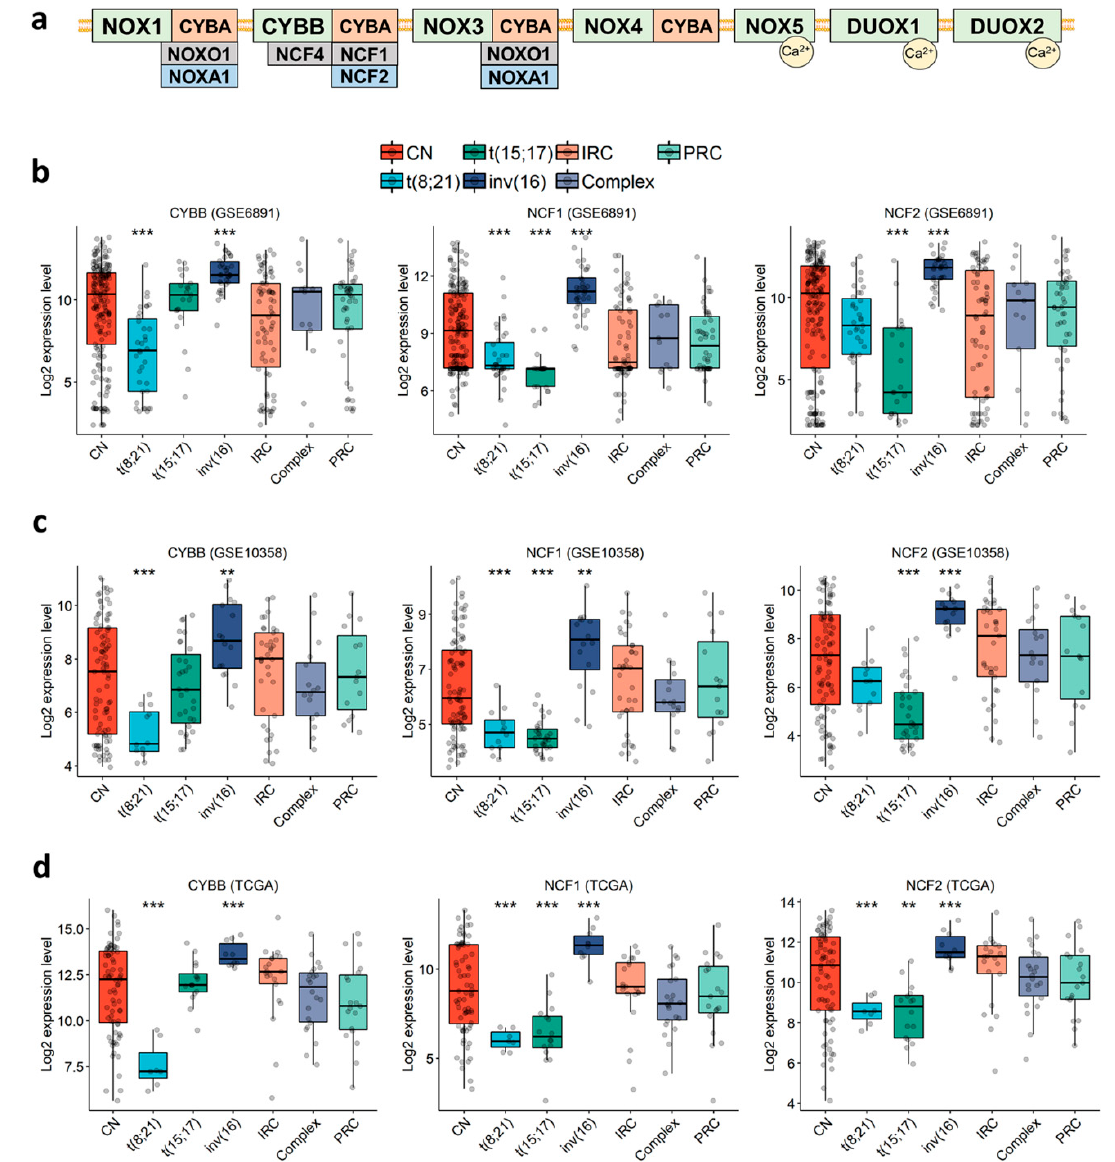
Figure 1. Expression profile of genes coding for CYBB, NCF1, and NCF2 in primary AML, according to cytogenetic abnormalities. ( a ) Schematic representation of the seven NOX complexes (NOX1-5 and DUOX1-2) and their 13 subunits. The analysis was performed in the ( b ) GSE6891, ( c ) GSE10358, ( d ) TCGA datasets. Student’s t-test followed by Benjamini-Hochberg (BH)-adjustment was used to compare each karyotype to all of the others combined. **: p < 0.01; ***: p < 0.001. CN: cytogenetically normal. IRC: intermediate risk cytogenetics. PRC: poor risk cytogenetics.